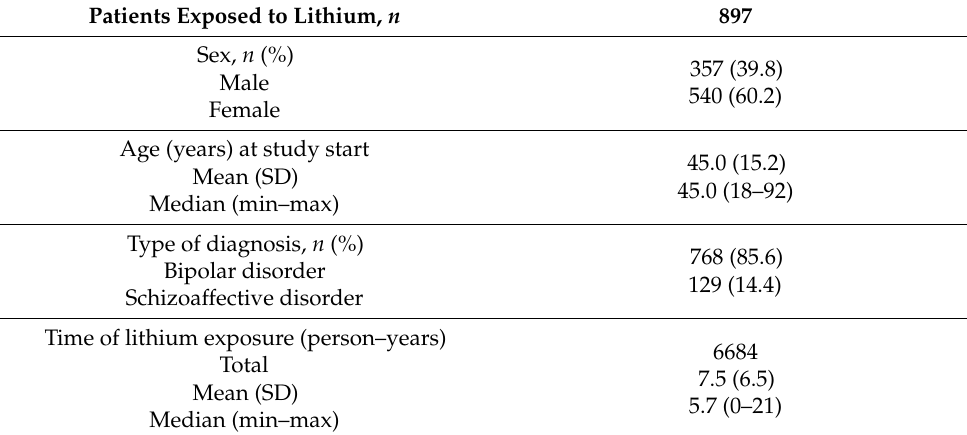
Table 2. Baseline characteristic of